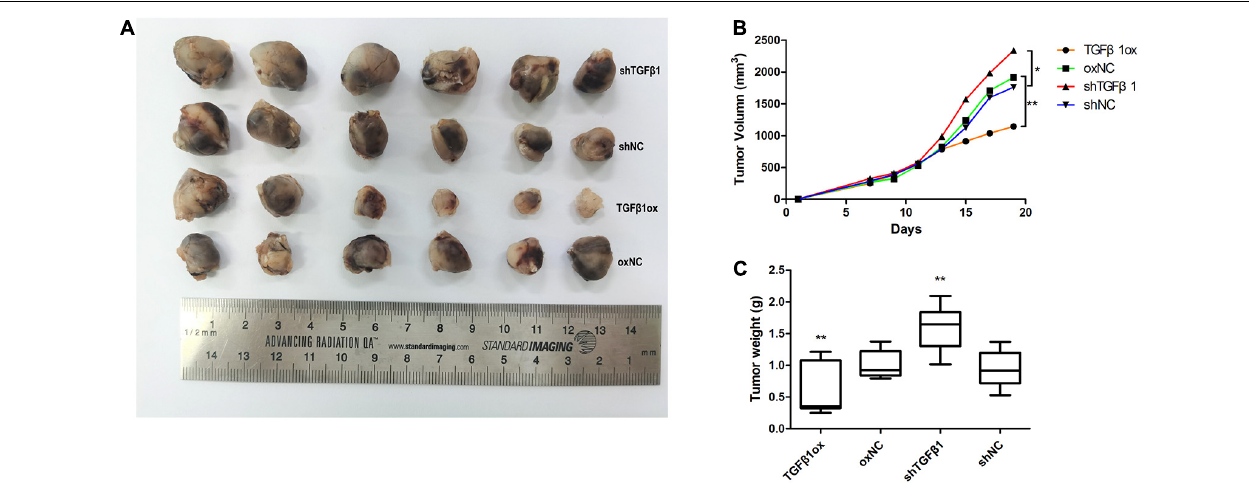
FIGURE 5 | Tumor volume and weight of xenografts were measured with calipers and electronic balance. (A) TGF β 1 level in CAFs affected the proliferation of lung cancer cells xenografts. (B) The mean tumor volume in shTGF β 1, shNC, TGF β 1ox and oxNC were 2341.62 ± 305.32 mm 3 , 1760.65 ± 428.63 mm 3 , 1143.87 ± 166.57 mm 3 , and 1917.78 ± 415.77 mm 3 , respectively. (C) The mean tumor weight in shTGF β 1, shNC, TGF β 1ox and oxNC were 1.59 ± 0.57 g and 0.94 ± 0.41 g, 0.59 ± 0.23 g and 1.01 ± 0.22 g, respectively. Statistical significance is shown (* p < 0.05; ** p < 0.01). shNC and oxNC: control groups corresponding to knockdown and overexpression of TGF β 1 recombinant lentiviral infection; shTGF β 1 and TGF β 1ox: knockdown and overexpression of TGF β 1 recombinant lentiviral